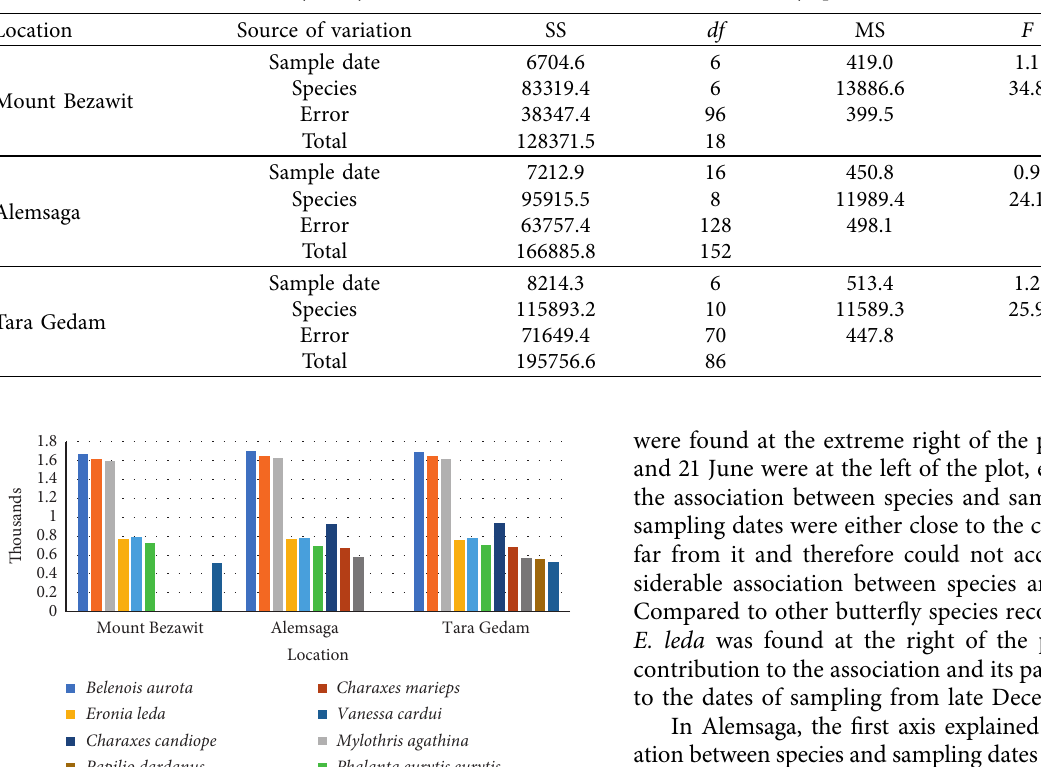
Table 4: Two-way analysis of variance tables for abundance of butterfly species at different locations.